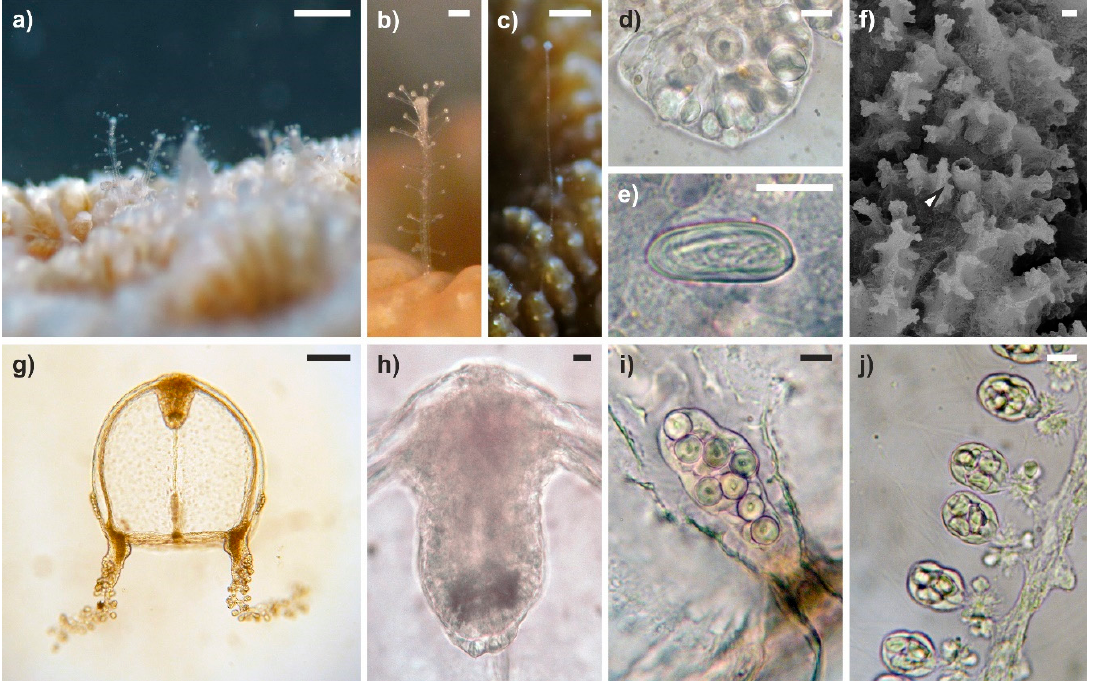
Figure 6. Zanclea sp. (Clade I). ( a ) Colony associated with Goniastrea sp.; close-ups of ( b ) gastrozooid and ( c ) dactylozooid; ( d ) stenoteles in the capitula, and ( e ) eurytele in the hypostome; ( f ) micro-alteration of the coral skeleton (arrowhead); ( g ) newly released medusa; close-ups of ( h ) manubrium, ( i ) nematocyst pouch, and ( j ) cnidophores. Scale bars: ( a,c ) 0.5 mm; ( b,f,g ) 0.1 mm; ( d,e,h–j ) 10 μ m.